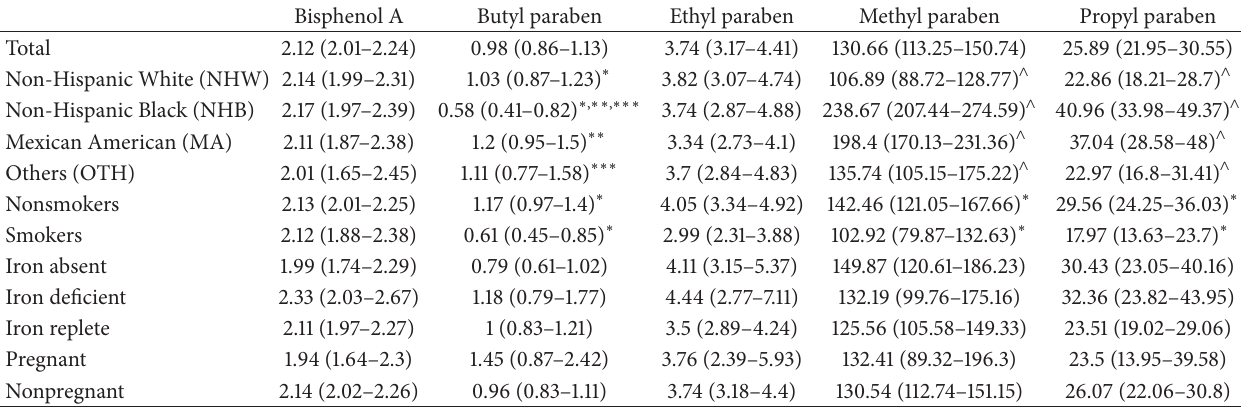
Table 2: Unadjusted geometric means in ng/mg creatinine with 95% confidence intervals for selected endocrine disrupting chemicals for females aged 20–44 years. Data from the National Health and Nutrition Examination Survey 2005–2010 # .